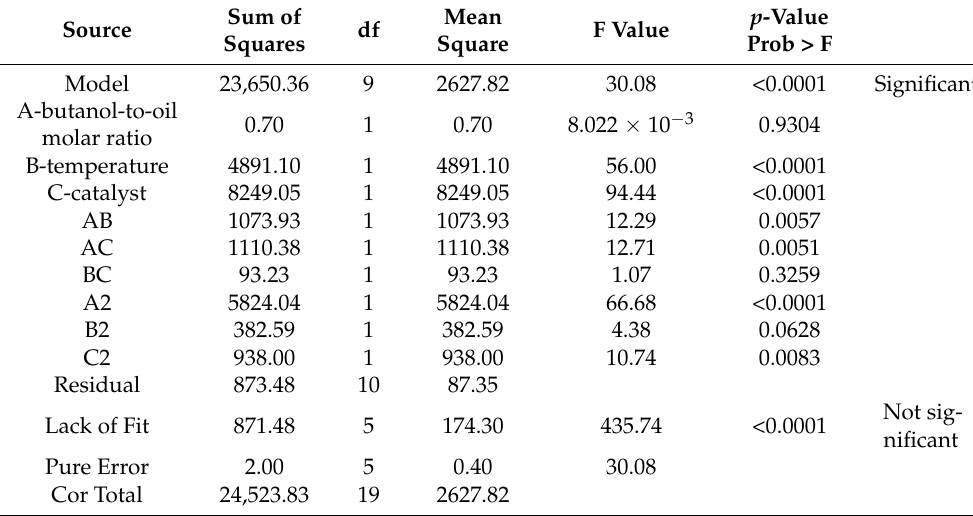
Table 2. Analysis of the variance of the quadratic model.